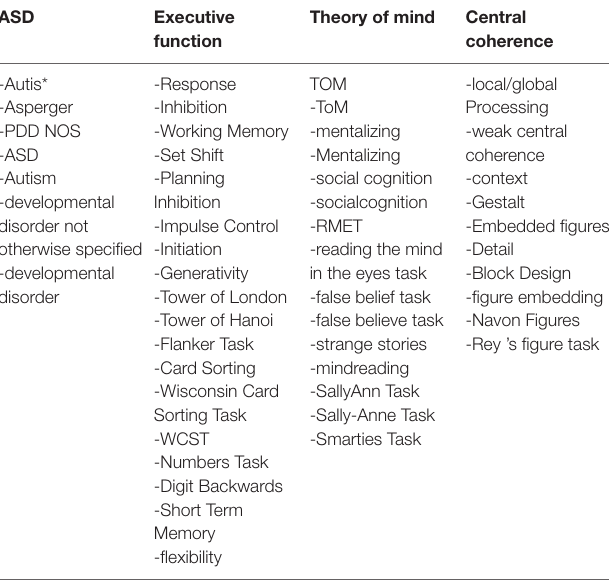
-Navon Figures -Rey ’s figure